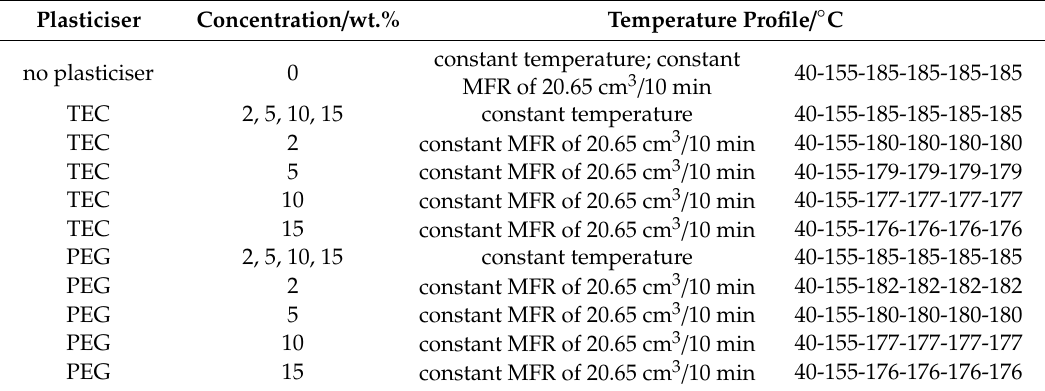
Table 1. Applied temperature profiles during extrusion for paper coating. TEC, triethyl citrate; PEG, polyethylene glycol; MFR, melt flow